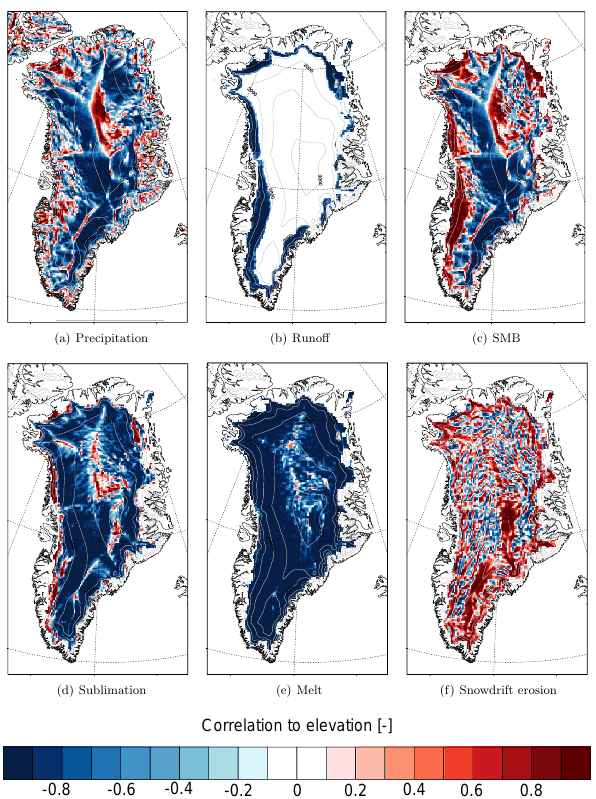
Figure 3. Correlation to elevation of annual mean (a) total precipita- tion (solid and liquid), (b) runoff, (c) SMB, (d) sublimation, (e) melt and (f) drifting snow erosion modelled by RACMO2.3 and calcu- lated on the 11km grid for the period